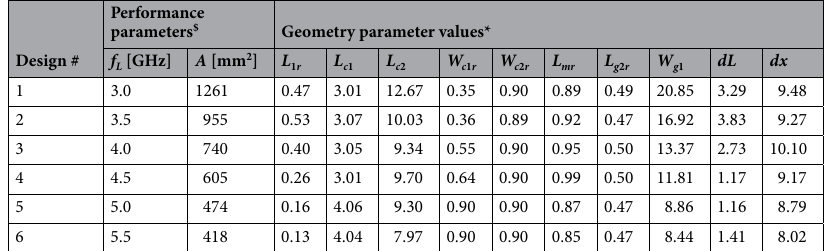
Performance parameters